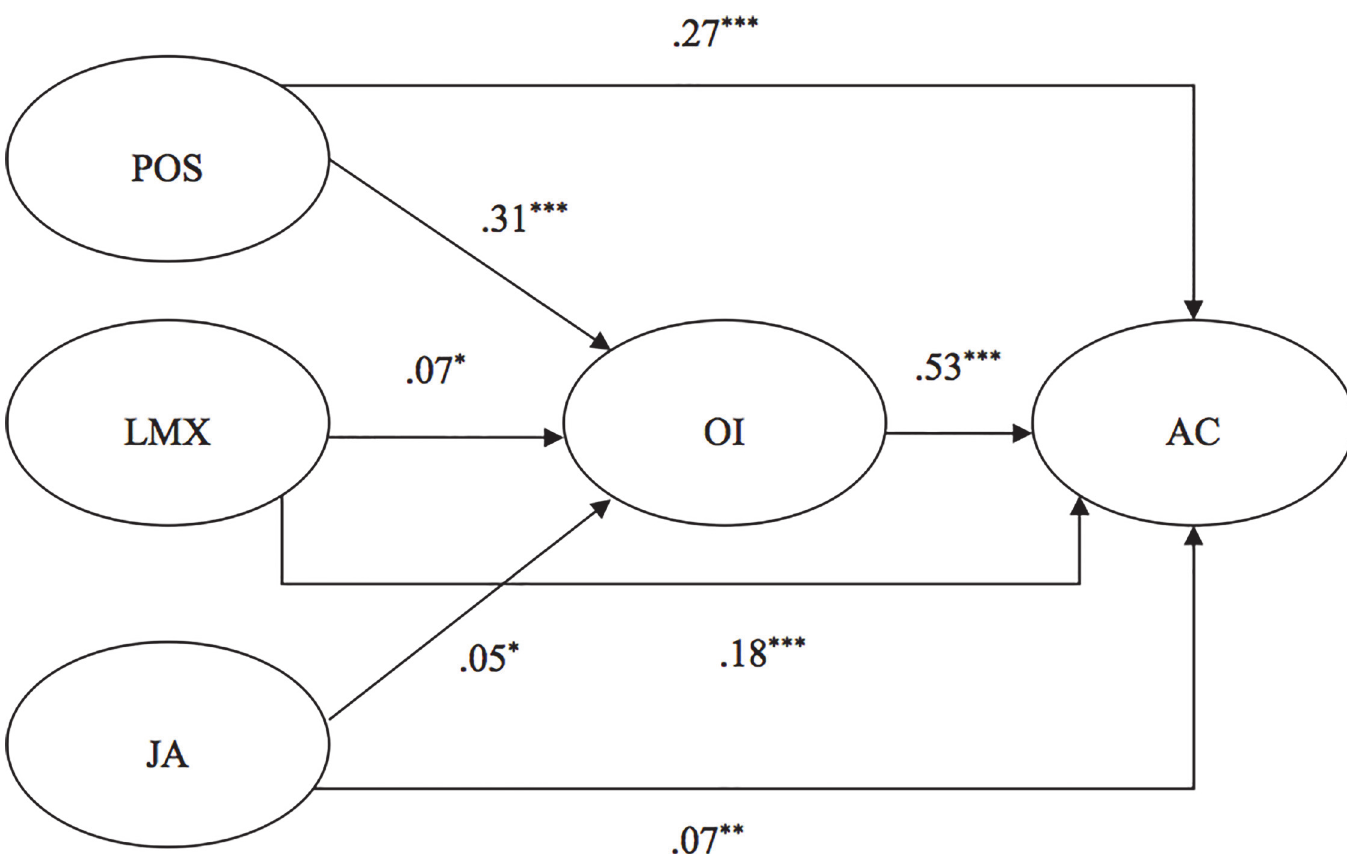
Fig 2. Study 2: Completely Standardized Path Coefficients for the Alternative Model 3. POS = perceived organizational support; LMX = leader-member exchange; JA = job autonomy; OI = organizational identification; AC = affective organizational commitment. For the sake of clarity, only structural relationships are shown. * p < .05. ** p < .01. *** p <